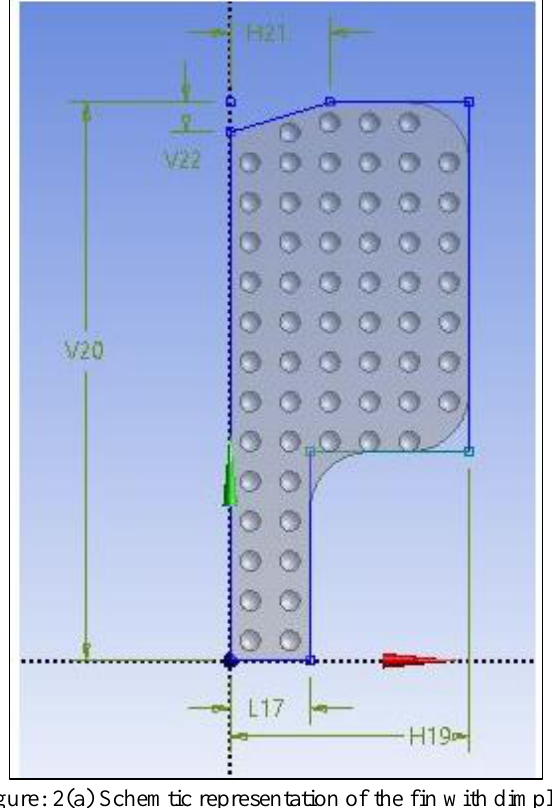
Figure: 2(a) Schemtic representation of the fin with dimples.